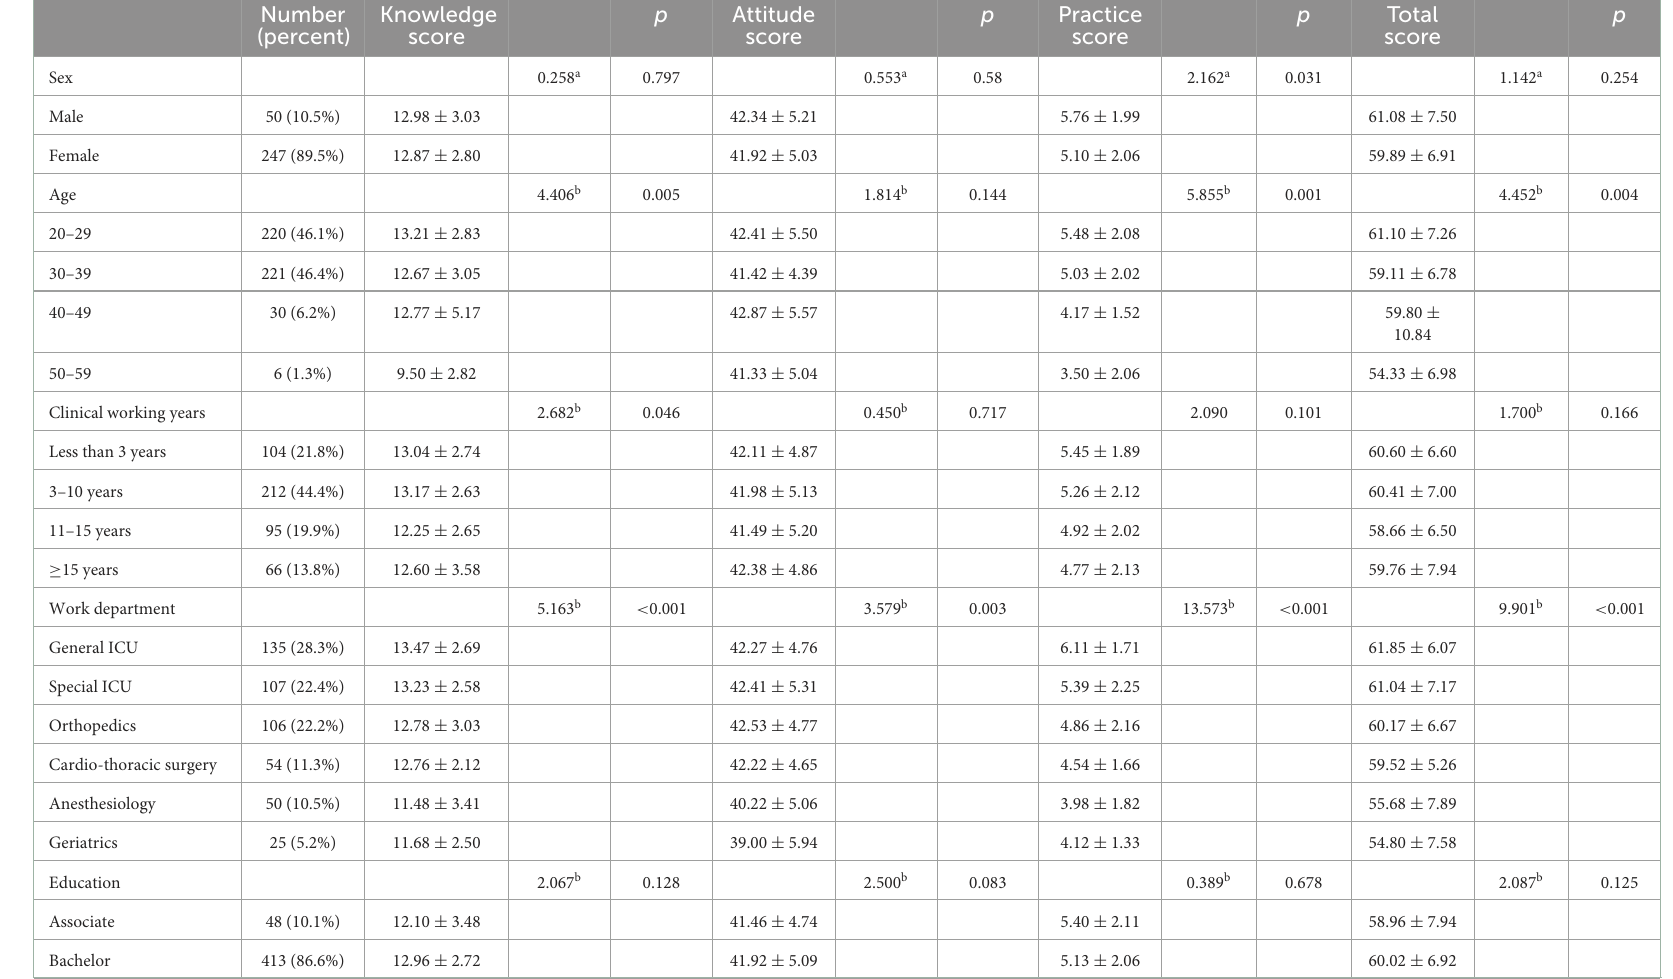
TABLE 1 Demographic characteristics of participants and one-way ANOVA analysis of delirium and subtype assessment for clinical nurses ( n =